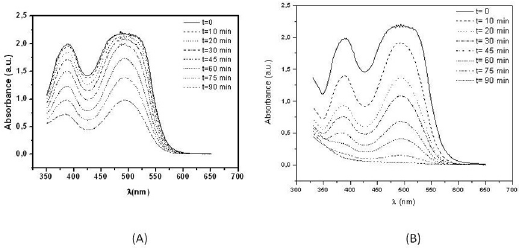
Figure 5. Absorption spectra of RO16 dye solutions at 50 mA cm -2 (a) K